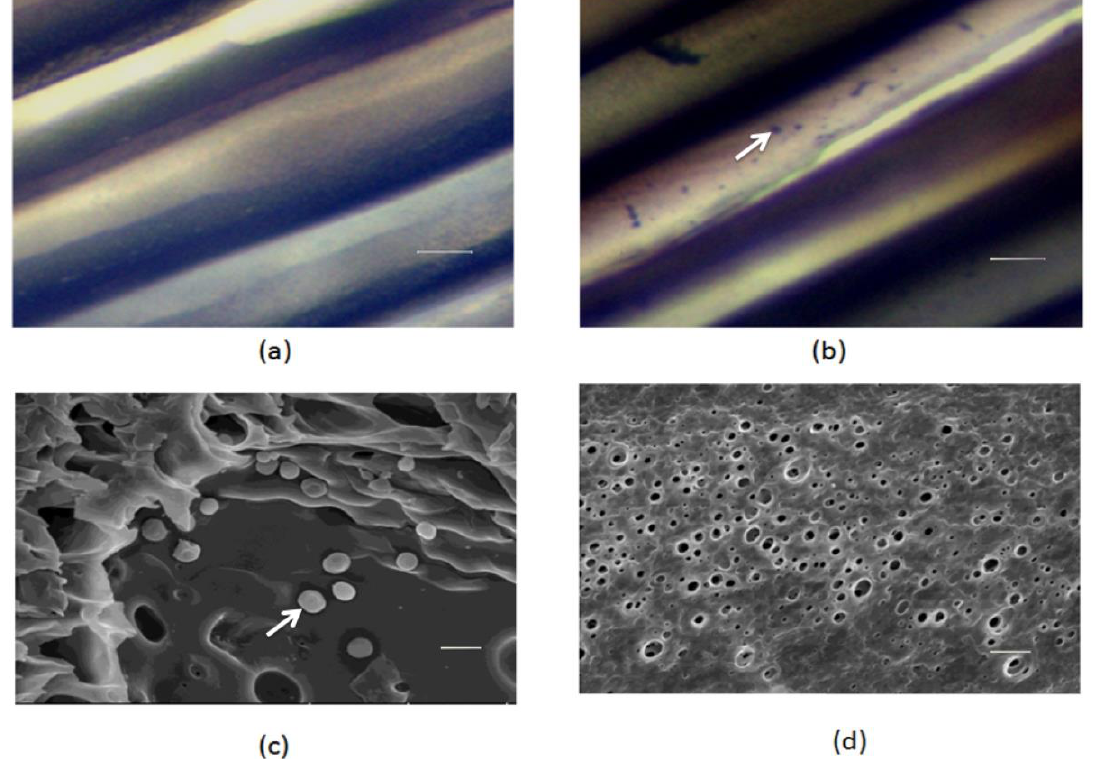
Figure 1. The light microscopy images of S. epidermidis ( a ) un-loaded and ( b ) loaded polysulfone microtube array membranes (PSF MTAMs) and the scanning electron micrographs (SEM) of inner ( c ) and outer ( d ) surfaces of S. epidermidis -loaded PSF MTAMs. Arrows indicate the S. epidermidis . Bars ( a , b ) = 10 µm; and ( c , d ) = 1 µm.